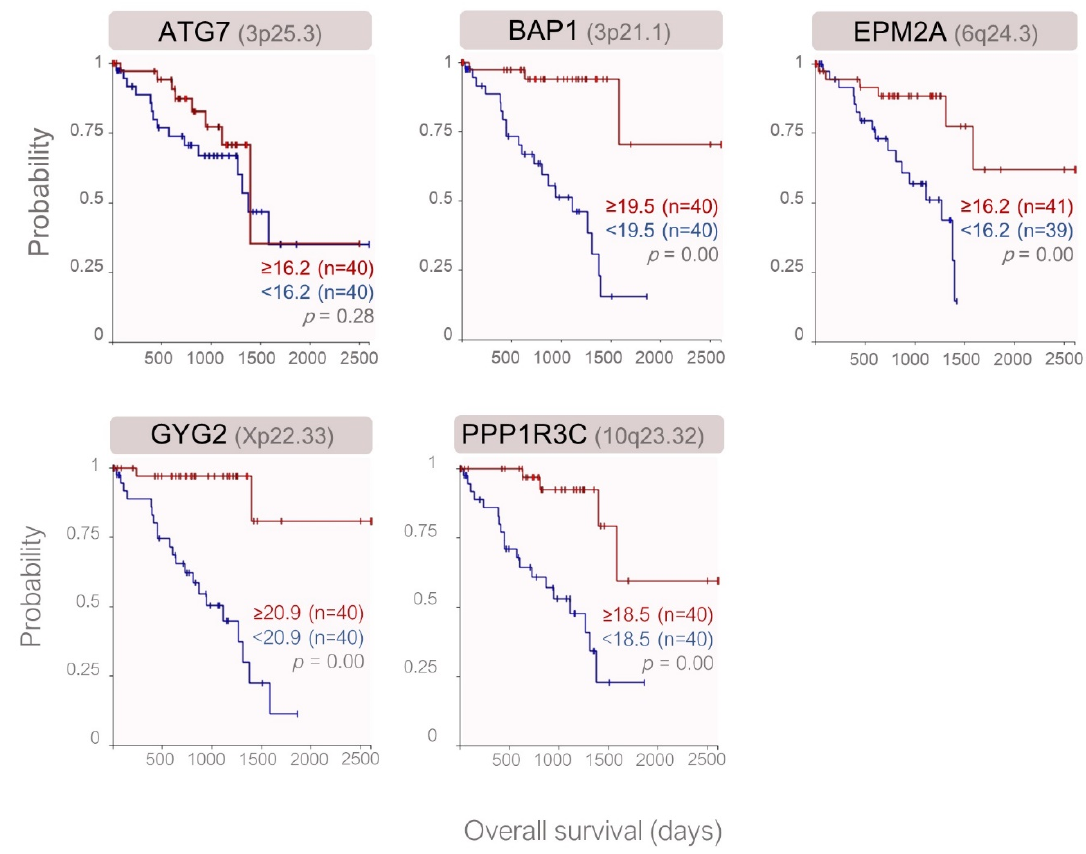
Figure 5. Kaplan–Meier curves demonstrating the probability of overall survival with respect to the expression of the validated genes in the primary UM samples of the TCGA study. The median mRNA level of each gene was taken as the cut-off value. Gene loci are indicated in parentheses following the gene symbol. All the presented genes function as positive regulators of glycogen synthesis. p -Values were determined by the log-rank test.